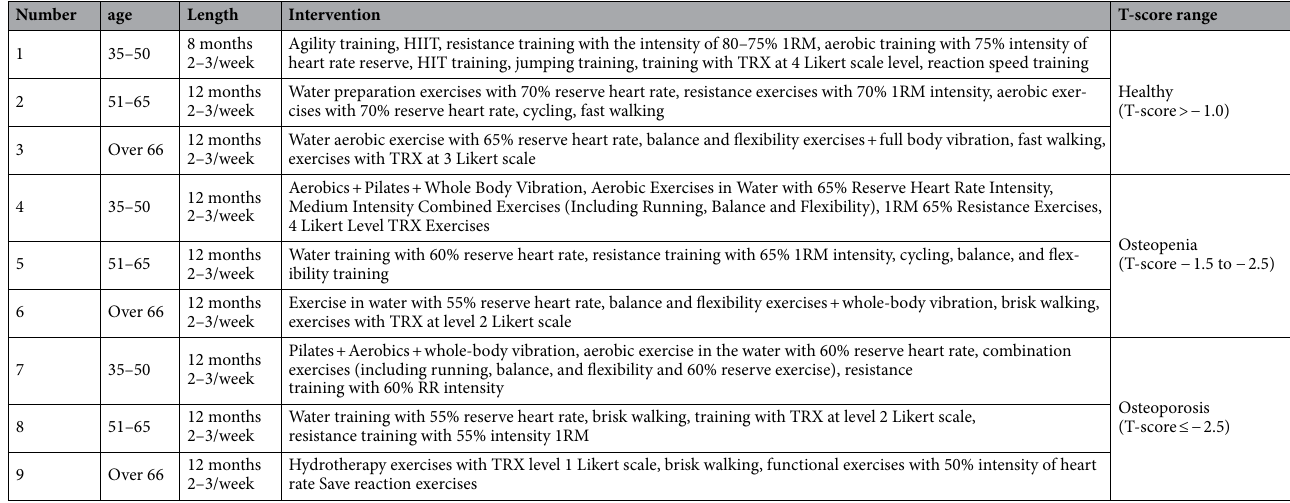
Models AUROC Accuracy Precision Sensitivity specificity F-score